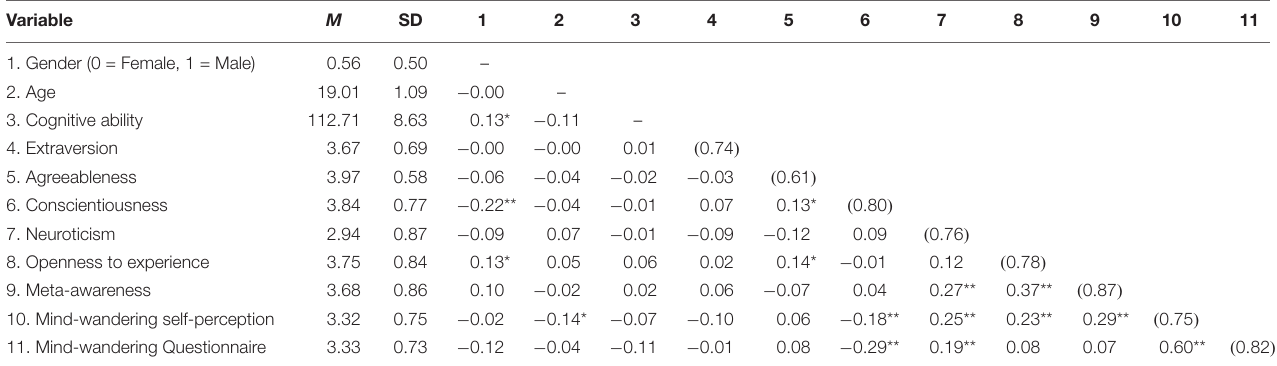
TABLE 1 | Descriptive statistics, reliabilities, and correlations.